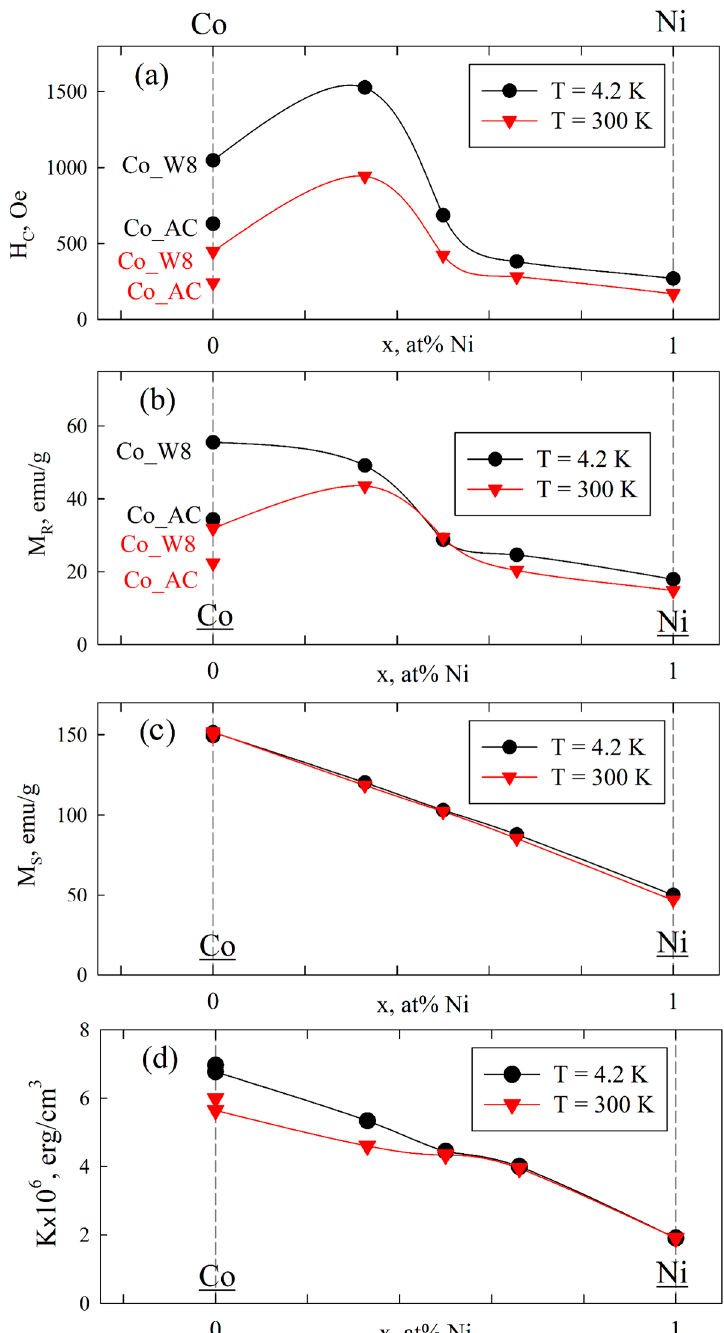
Figure 7. Concentration (x in Co 1 − x Ni x ) dependencies for coercivity (HC) ( a ), remanent magnetiza- tion (M R ) ( b ), saturation magnetization (M S ) ( c ), and magnetic anisotropy constant (K) ( d ) for the studied series of samples at 4.2 and 300 K. Solid curves are visual guides. In ( a , b ), data for Co_AC and Co_W8 are marked in the graphs. In ( d ), data for Co_AC are shown without “guide